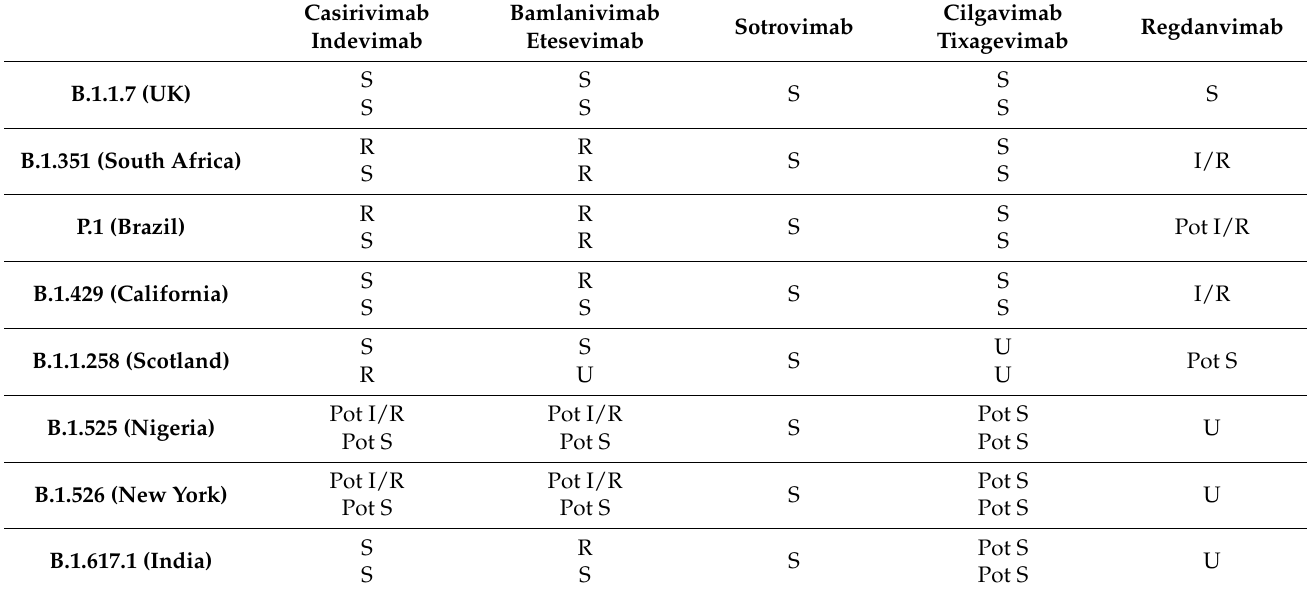
Table 5. Mutations of SARS-CoV-2 S in VOC and resistance profile of clinical mAbs